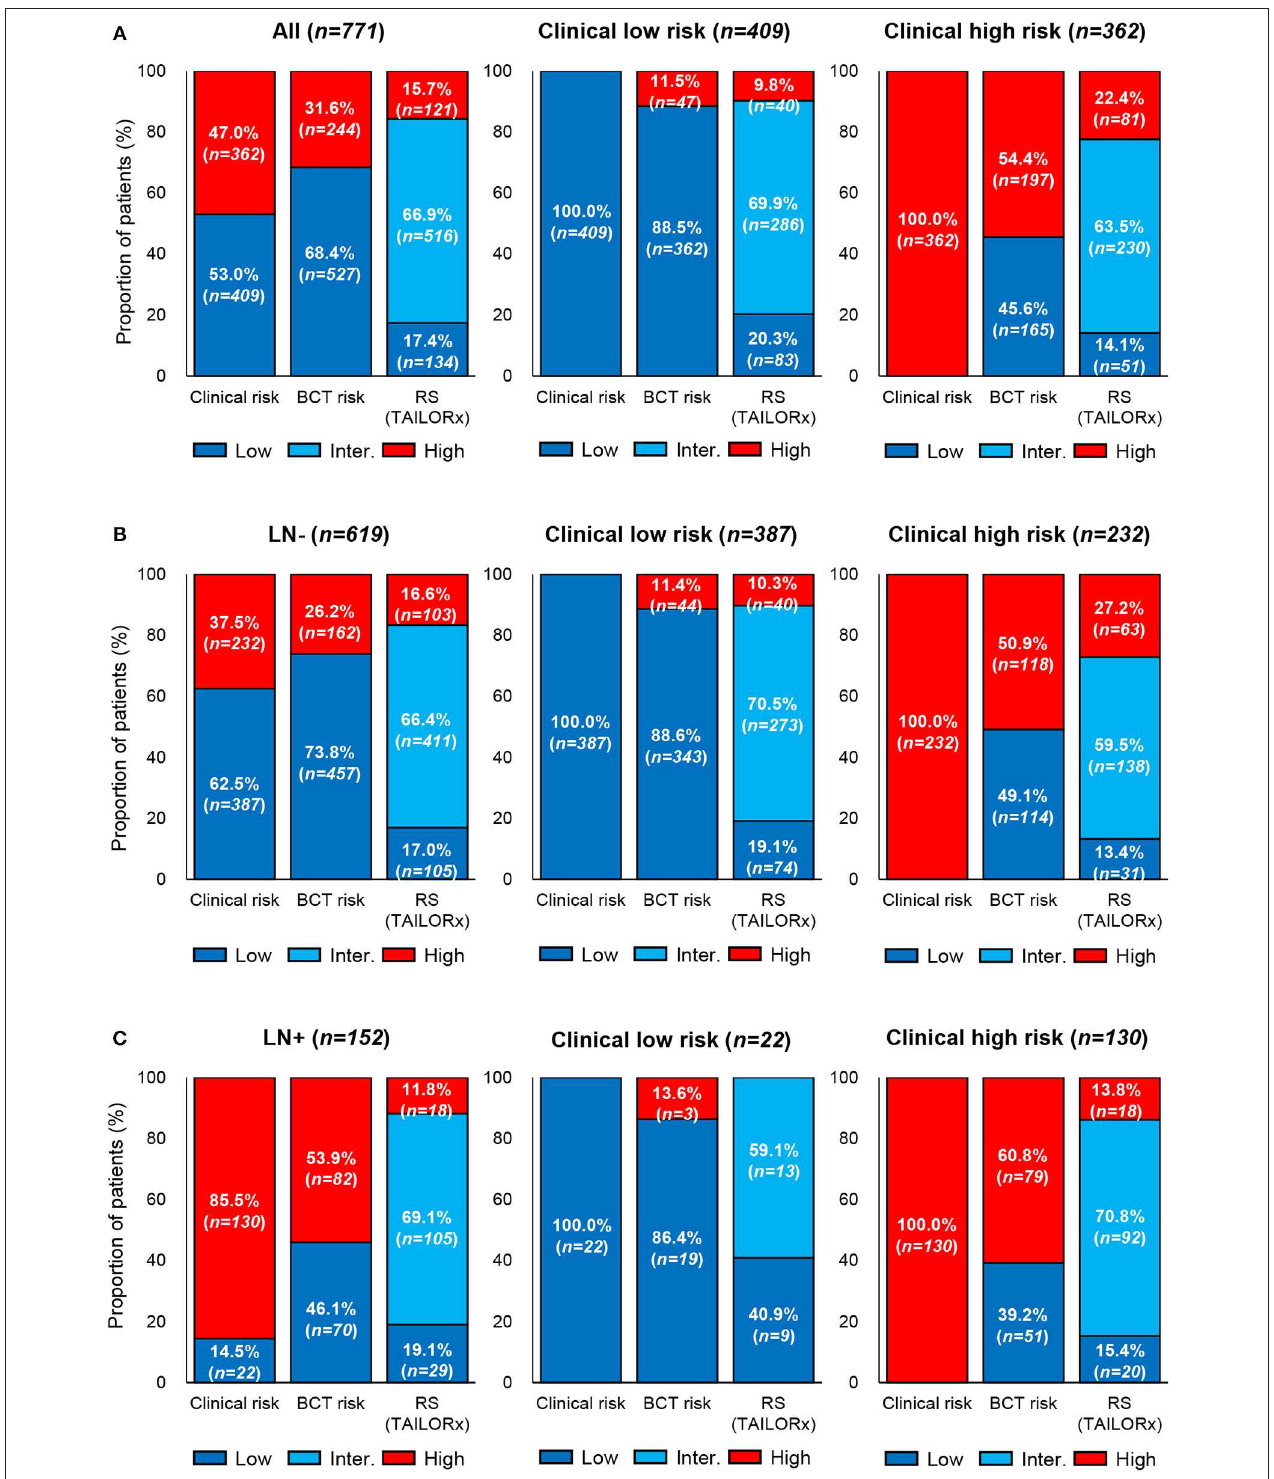
FIGURE 3 | Comparison of clinical risk with the risk classification by the BCT score or Oncotype DX RS. Proportion of patients within each risk group according to clinical risk assessment, BCT score, or RS in (A) all patients ( n = 771), (B) lymph node-negative (LN-) patients ( n = 619), and (C) lymph node-positive (LN + ) patients ( n = 152). Clinical risk was determined using the modified Adjuvant! Online, as reported in the MINDACT trial. Risk classification by the RS was based on the recurrence score ranges used in the TAILORx.